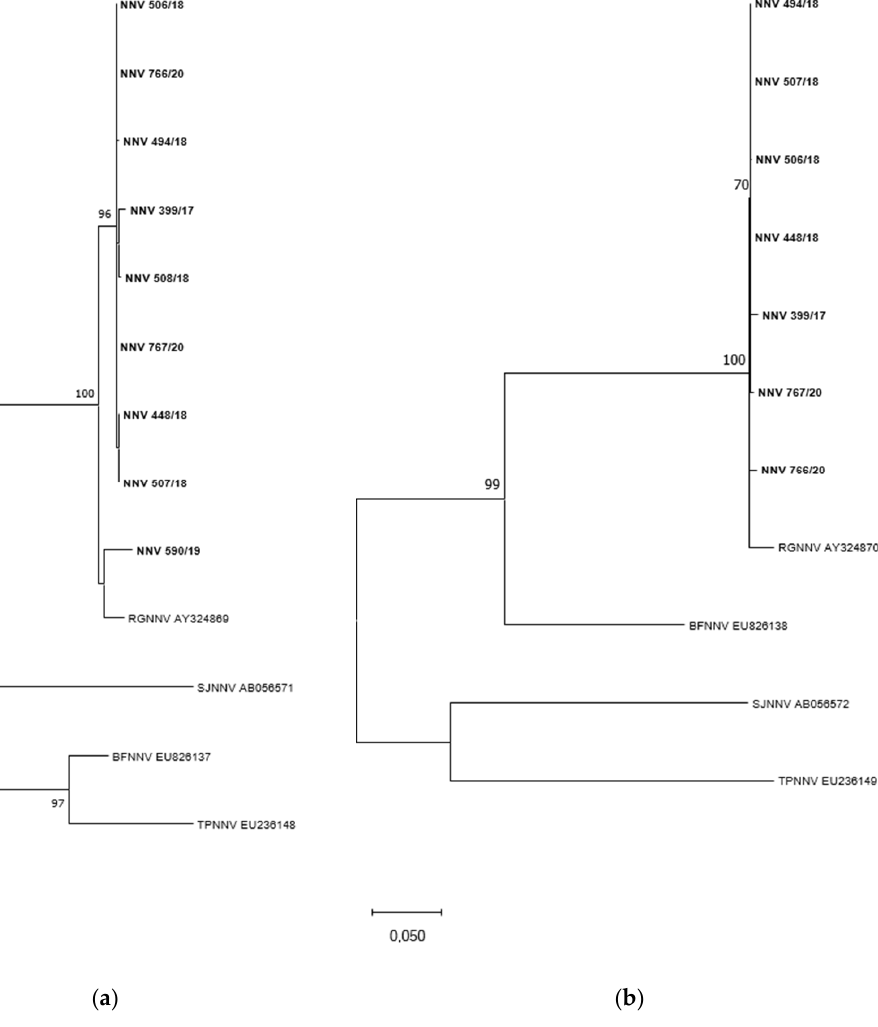
Figure 2. Maximum likelihood phylogenetic tree based on the partial RNA1 ( a ) and RNA2 ( b ) nucleotide sequences of NNV. Sequences obtained in this study are in bold. Sequences retrieved from GenBank are reported with the genotype name and the accession number. Bootstrap values >70% are shown. Branch lengths are scaled according to the number of nucleotide substitutions per site. The scale bar is reported.